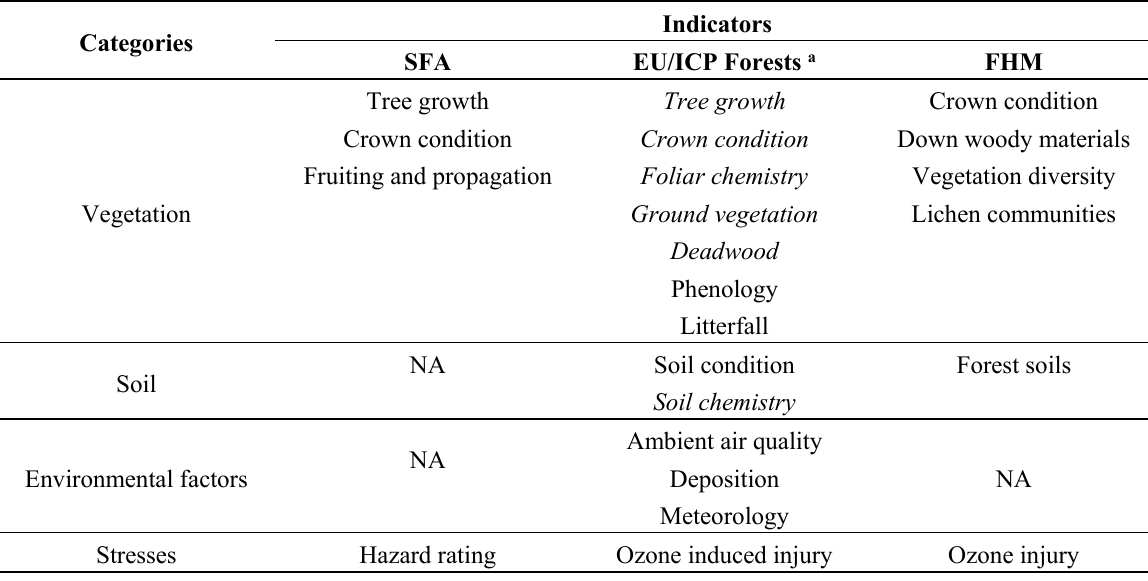
Table 8. Comparisons of forest health indicators used by SFA [20], EU/ICP Forests [11], and FHM